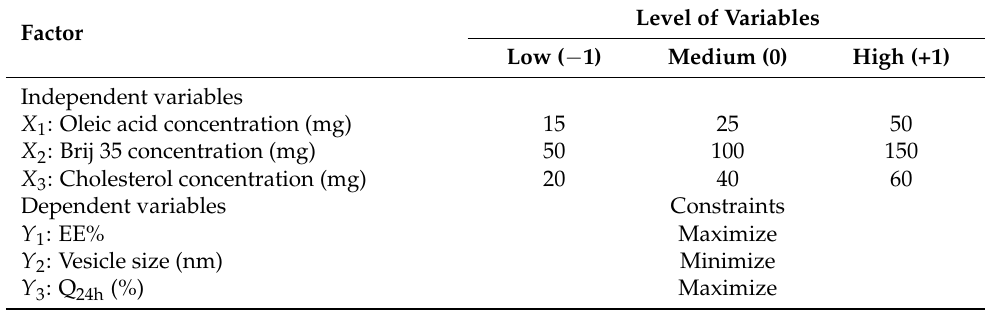
Table 1. Box–Behnken design parameters, and constraints for QRC-NOVs.